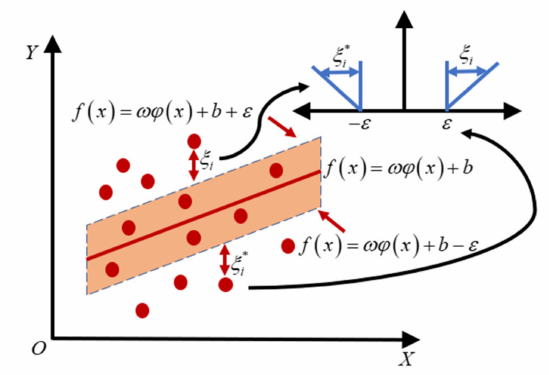
Figure 3. Support vector regression